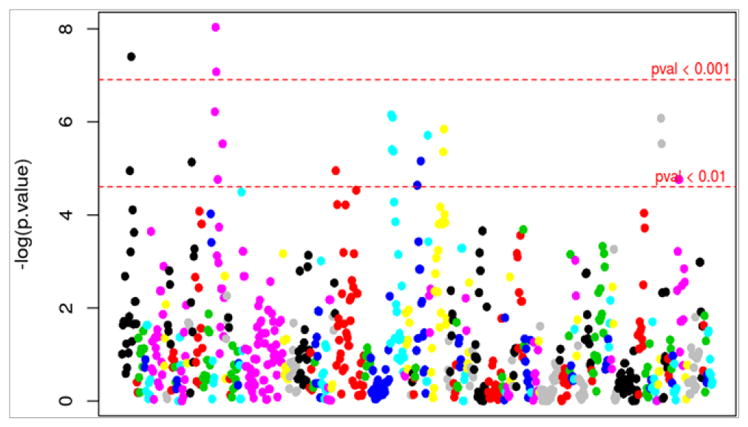
Markers associated with drought identified using Principal Component Analysis followed by Multivariate Analysis of Variance in different linkage groups (color-coded). The Y axis displays the −log(p-value); where −log (0.01) ~ 4.6. A total of 22 significant associations were detected at p<0.01 based on the Pillai-Bartlett Trace test.